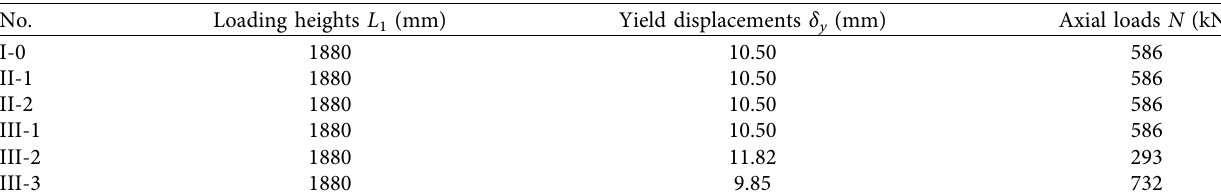
Figure 4: Loading procedure. Table 2: Loading